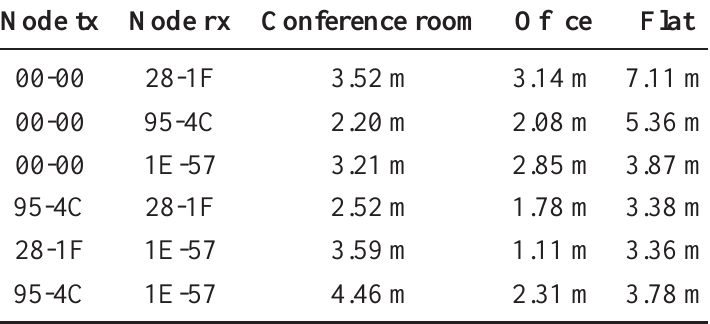
Table 3. Actual distances among the nodes for the three scenarios.